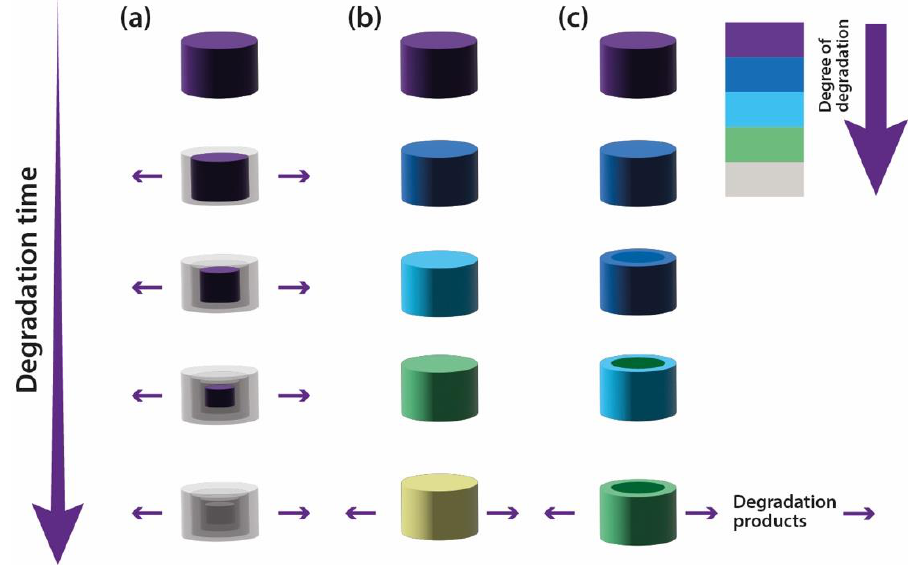
Figure 17. Degradation modes for degradable polymers: surface erosion ( a ), bulk degradation ( b ) and bulk degradation with autocatalysis ( c ). Adapted from [46].